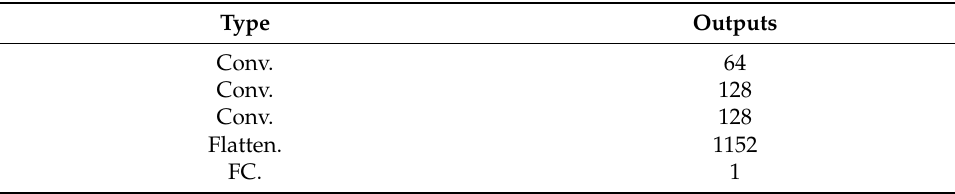
Table 3. Detailed parameters of global